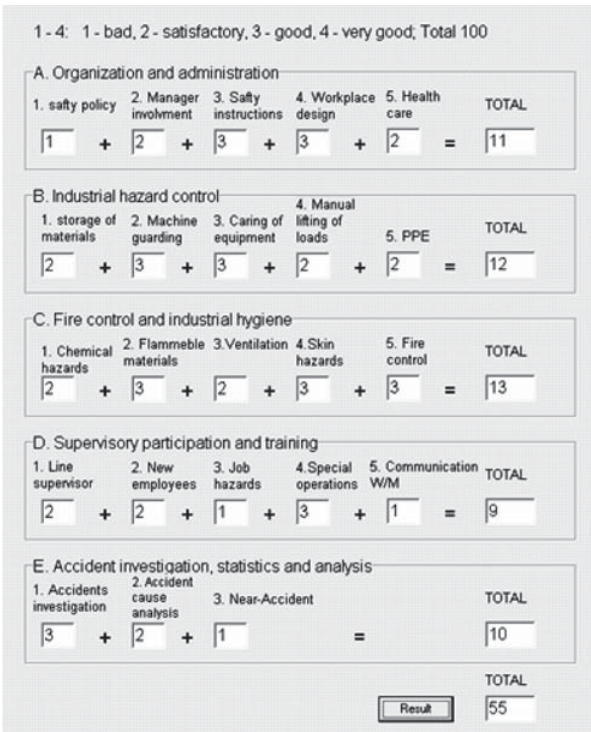
Fig . 3 . A simple computerized method for determination of safety level at